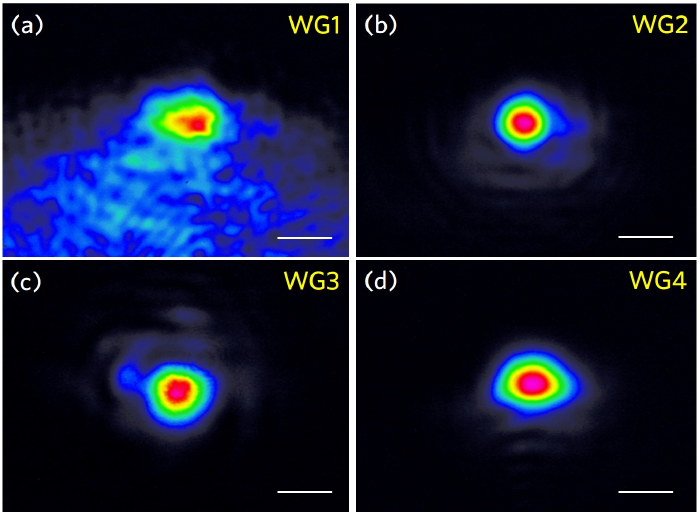
Figure 3. Measured near-field modal profiles of the Nd:YCOB channel waveguides produced by 2 MeV proton beam writing at fluences of ( a ) 1 × 10 15 , ( b ) 2 × 10 15 , ( c ) 5 × 10 15 , and ( d ) 1 × 10 16 ions/cm 2 at a wavelength of 632.8 nm. All the scale bars denote 5 μ m.